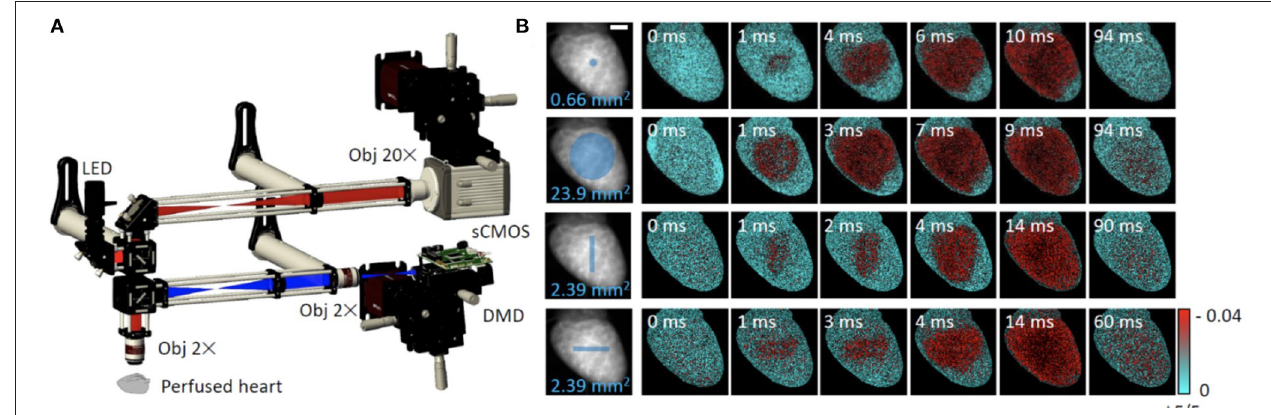
FIGURE 3 | (A) Optical setup for real-time closed-loop optogenetic stimulation with a digital micromirror device (DMD) in response to ongoing cardiac activity, simultaneously optically mapped with a sCMOS camera. (B) Exemplary customizable stimulation pattern and cardiac excitation wavefronts. Modified from Scardigli et al.